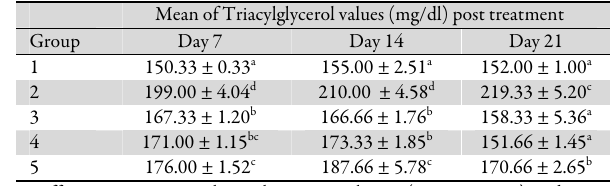
Table 4. The mean of yriacyglycerol values of alloxan induced diabetic rats treated with combinations of glibenclamide and aqueous extract of G.